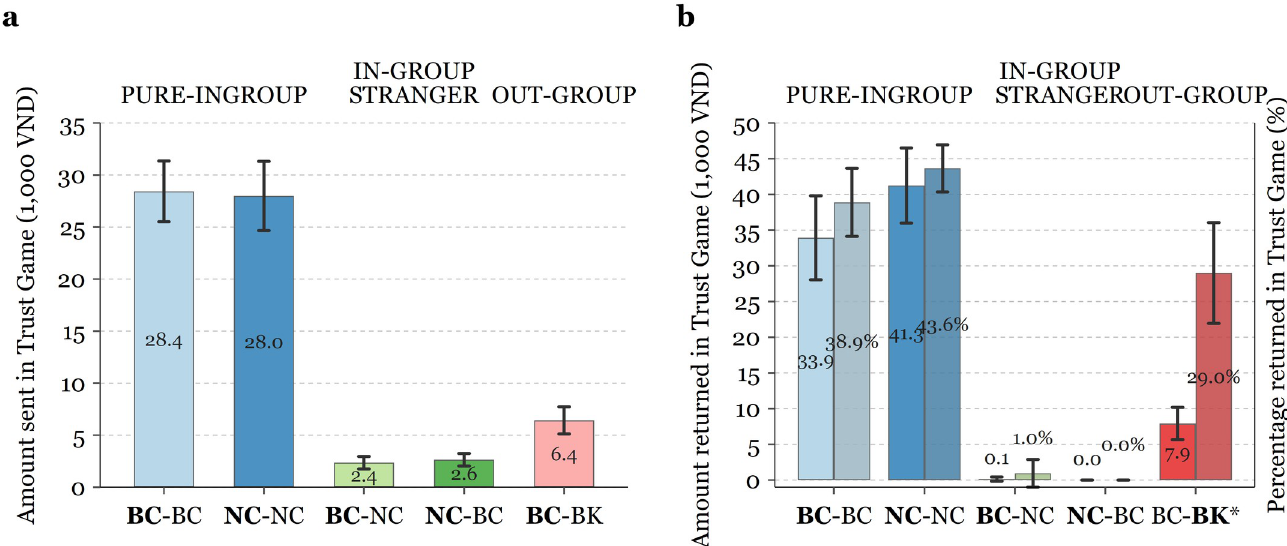
Fig 3. Amount transferred in the Trust Game, by treatment and session. Bar height indicates the average amount sent by Player 1 (panel a ) and the average amount returned (lighter bars), and percentage returned (darker bars) by Player 2 given non-zero amount received (panel b ). Error bars represent 95% confidence intervals. � Transfer by Minh Khai students